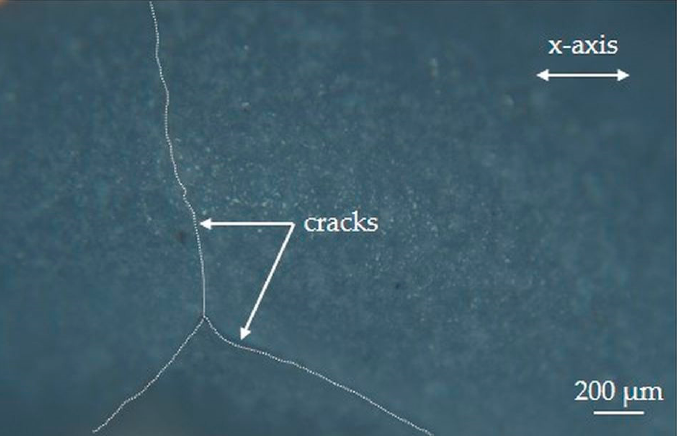
Figure 10. Comparison between simulated and measured evolutions of camber during thermal treatment.